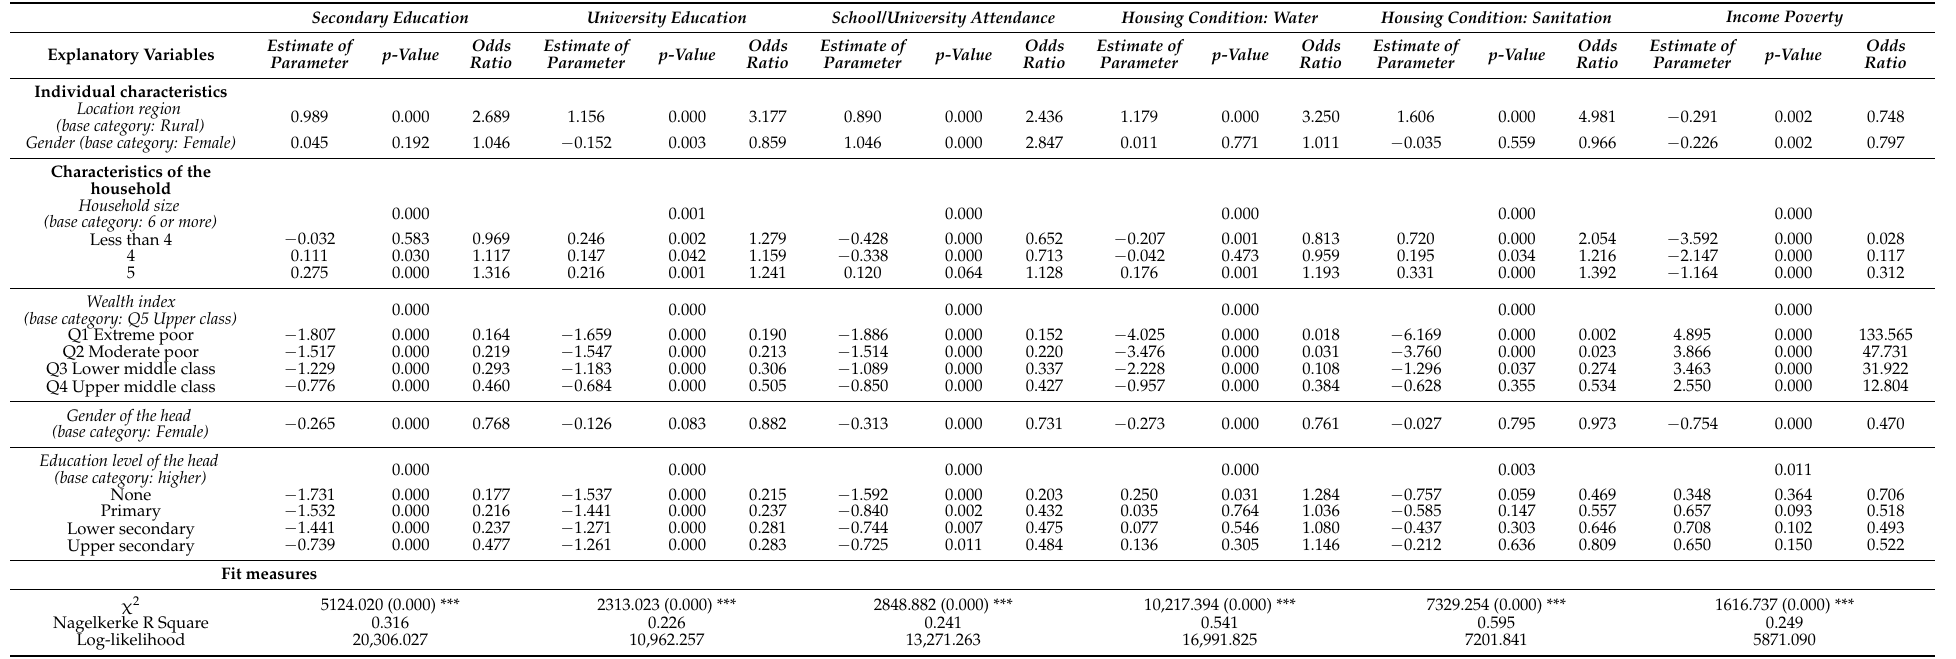
Table 7. The results of the estimation of the logit regression